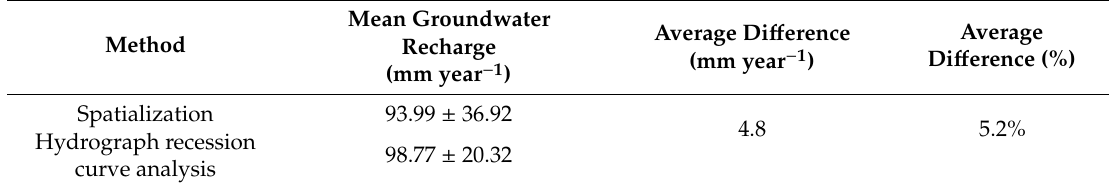
Table 9. Groundwater recharge in the Pandeiros River basin, estimated by the spatially distributed PUC-based and hydrograph recession analysis